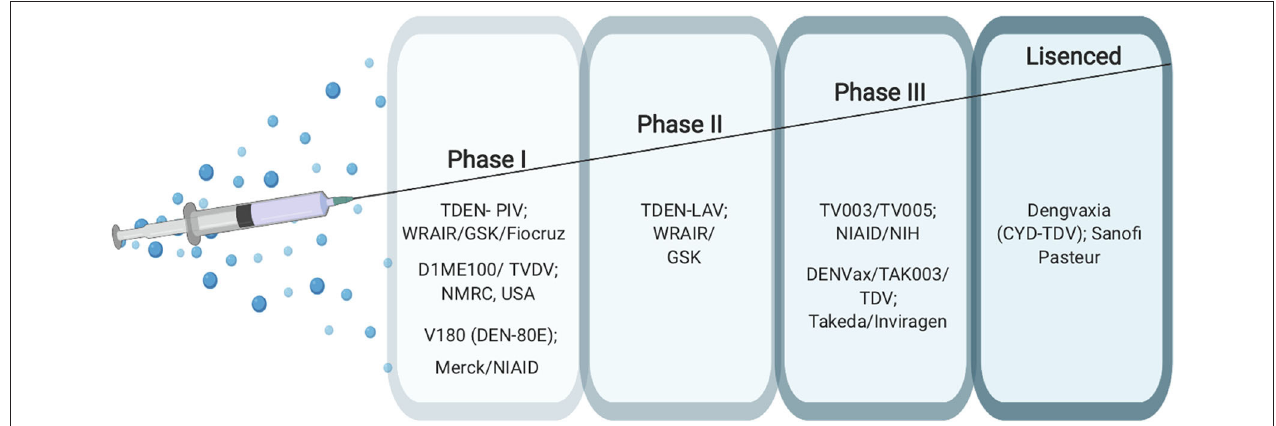
FIGURE 3 | Current dengue